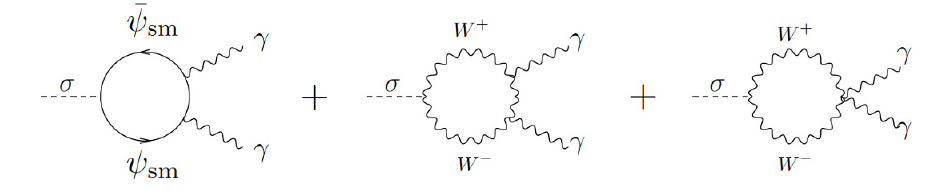
Figure 3 . Leading order diagrams that dilaton decays into two photons. The dashed line denotes dilaton and the solid line denotes SM fermions. The external curly lines denote photons and the internal curly lines denote W